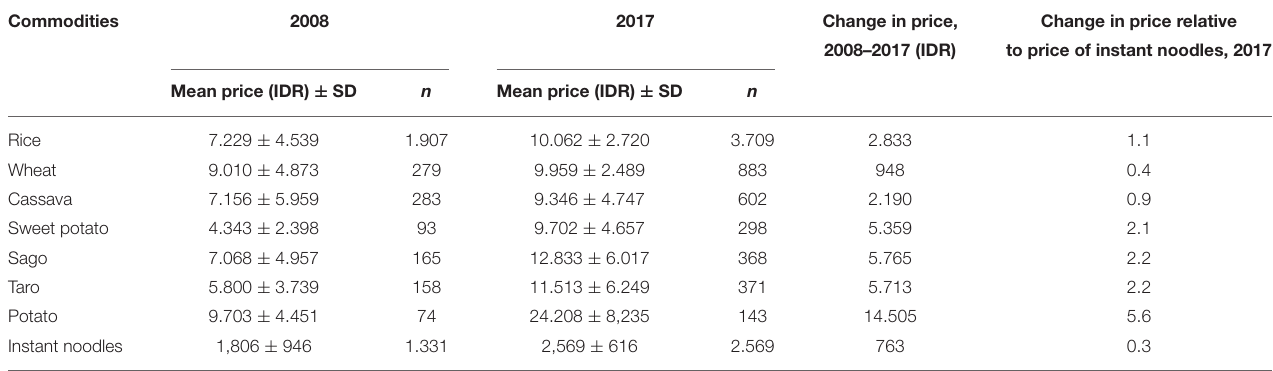
TABLE 2 | Change in price of staple foods between 2008 and 2017 relative to the price of instant noodles in 2017. Commodities 2008 Change in price,